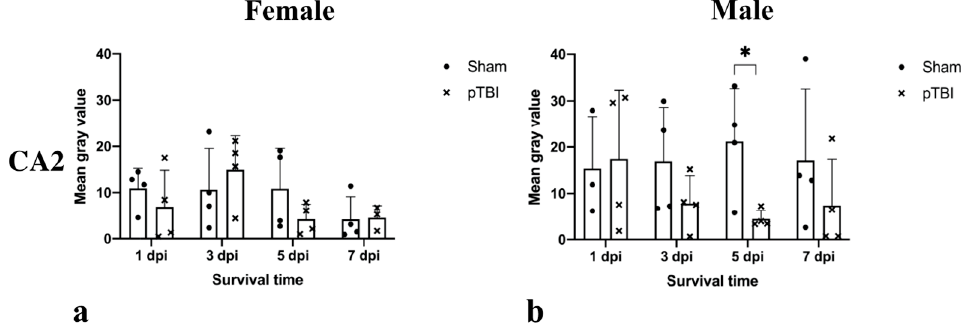
Figure 5. Comparison of CYP1B1 mRNA expression in hippocampal subregion CA2 in rats subjected to either sham-surgery or pTBI. Animals in Sham received a craniotomy, while animals in pTBI received a craniotomy with a subsequent pTBI. Survival times analyzed were 1-, 3-, 5- and 7 days. CYP1B1 mRNA was detected by in situ hybridization. Graphs show a timeline over CYP1B1 mRNA expression in subregion CA2 of females ( a ) and males ( b ) subjected to either sham-surgery or pTBI. The mean gray value is presented in the Y-axis, showing the average mean gray area calculated from each measured cell for each subregion and animal. To calculate mean gray value, images were made binary and in-situ probes made black and separated from the white background. The gray value of the color black was set to 255 and the value for white to 0. The gray value of each cell is therefore a measurement of the area of cell marked by the in-situ probe. The gray values from each cell of each subregion were then used to calculate the mean gray value of each subregion and animal. The X-axis shows the survival time. Males show no change in CYP1B1 mRNA expression 1 dpi, but 3-, 5-, and 7 dpi expression is decreased in the groups receiving pTBI compared to those receiving sham-surgery ( b ). 5 dpi, males subjected to pTBI exhibited significantly lower expression compared to sham in CA2 ( p = 0.0349). The values are presented as mean + SD for each group, including the mean for each animal. Horizontal bars marked with “*” show differences where p < 0.05.